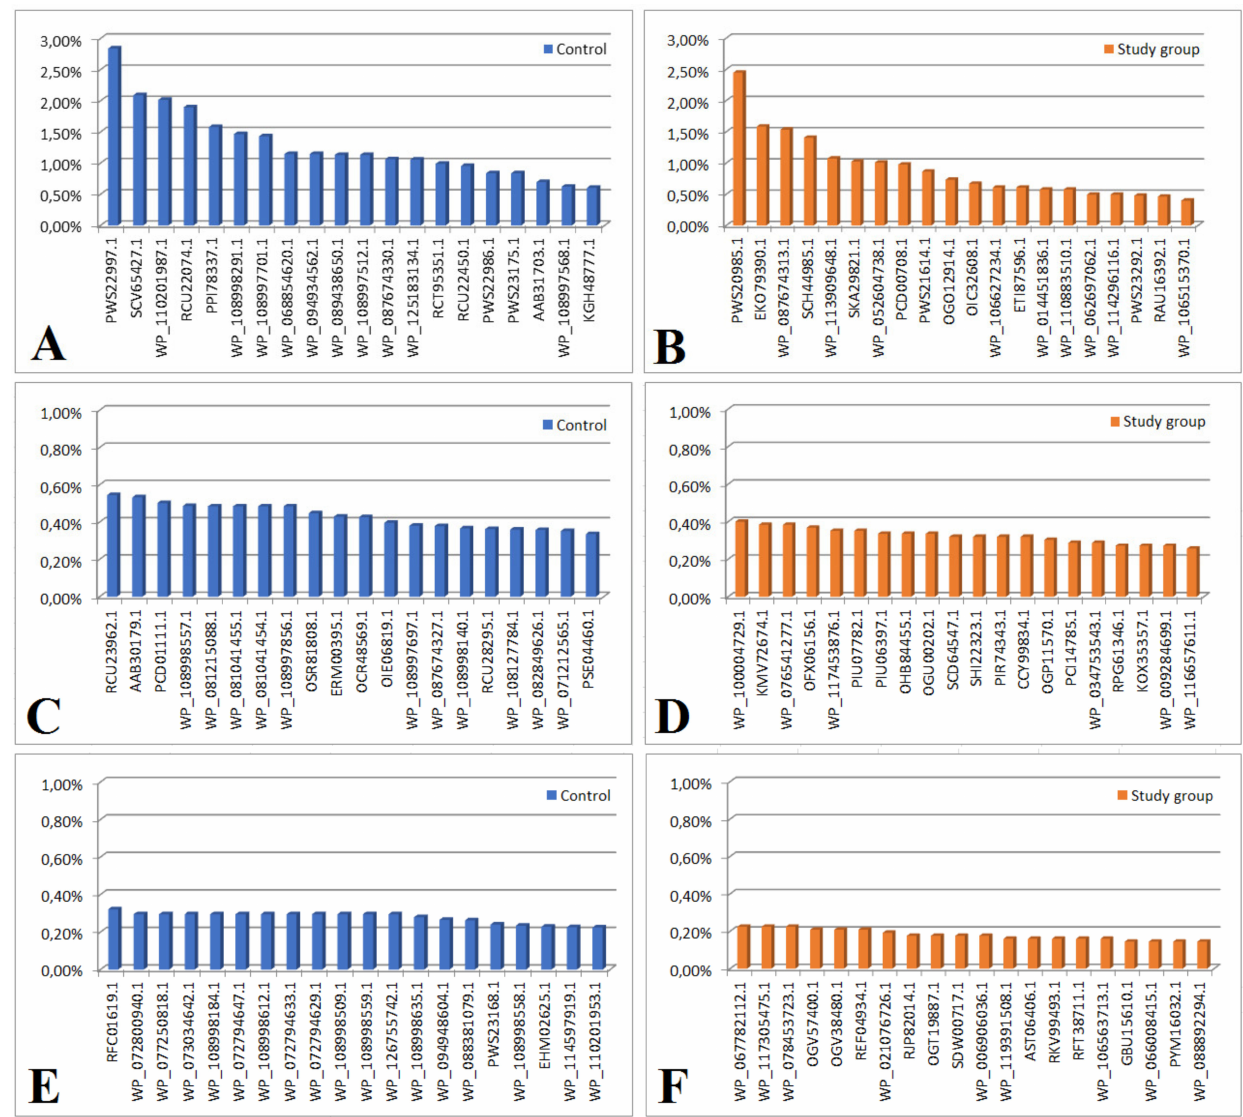
Figure 3. Bar graphs showing the content of proteins present only in the material from the study group or control. Graph showing the content of proteins (in order of decreasing emPAI value) found only in the material from the control group: proteins 1–20 ( A ); proteins 21–40 ( C ); proteins 41–60 ( E ) or tested: proteins 1–20 ( B ); proteins 21–40 ( D ); proteins 41–60 ( F ). Expressions from Figure 3 are explained in Table